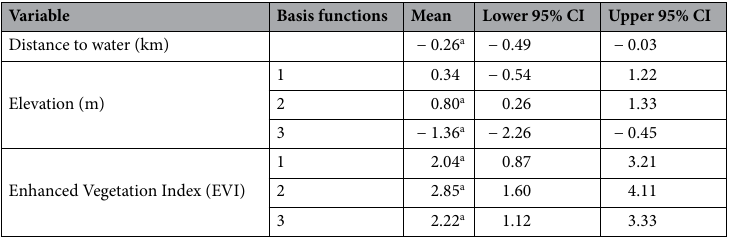
Table 3. The posterior means and the 95% credible intervals for the fixed effects parameters of the covariates used in the spatial model. a Statistically significant posterior mean value.